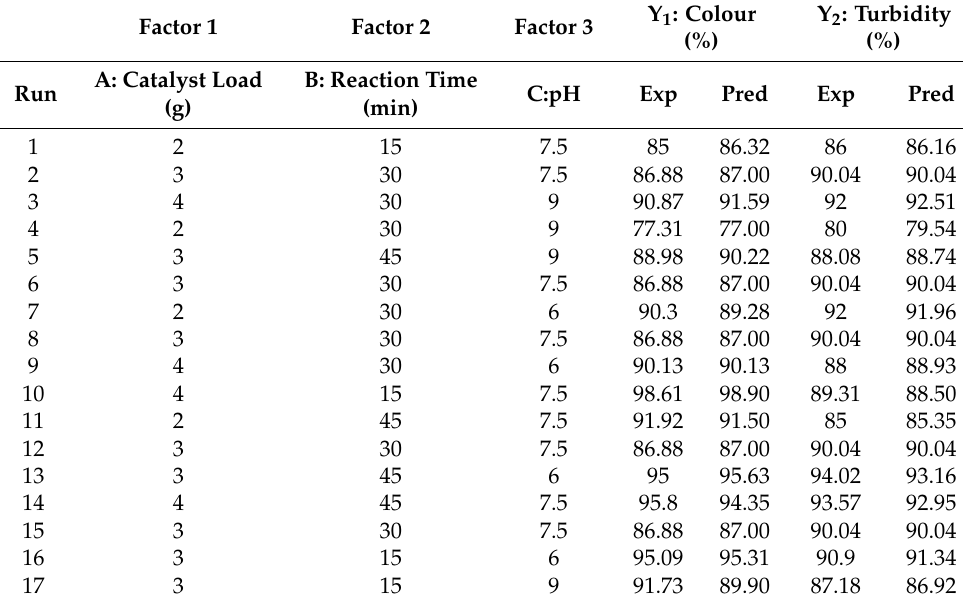
Table 2. Results of Box-Behnken design with experimental and predicted values. Factor 1 Factor